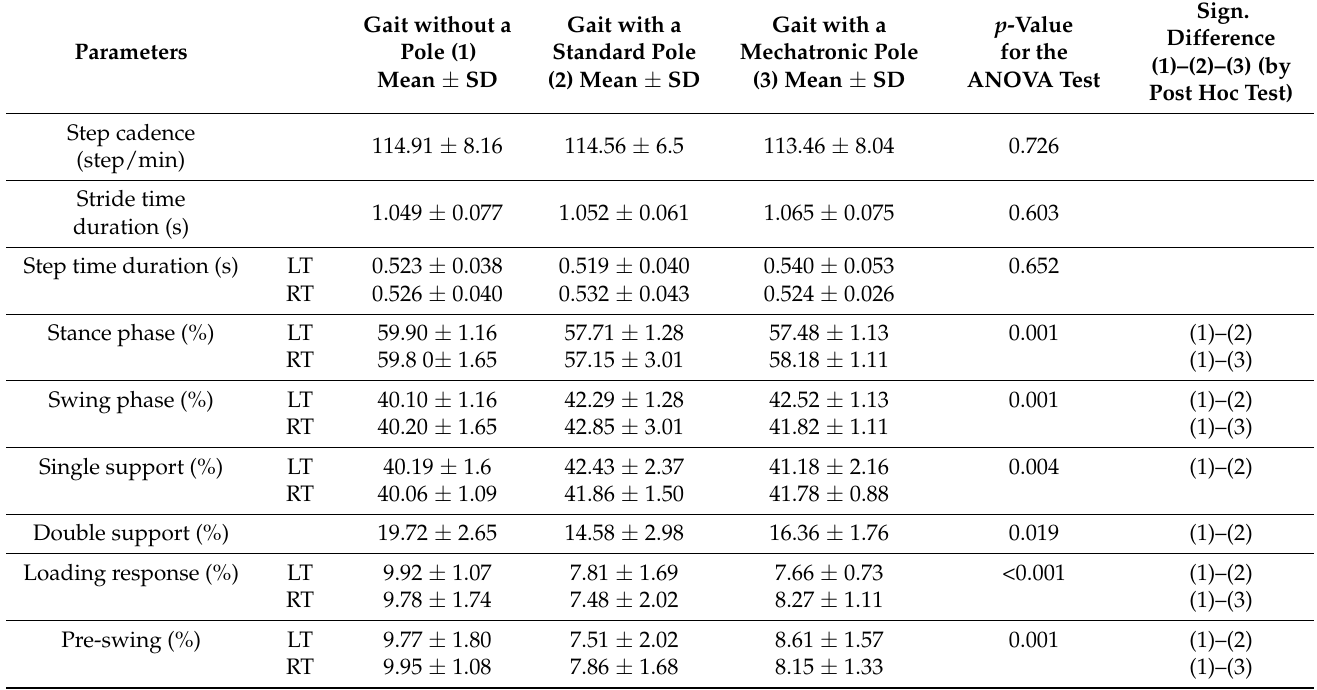
Table 2. Differences between measurements of temporal gait parameters: without a pole (1), with a standard pole (2), and with a mechatronic pole (3) for Nordic Walking professionals ( n = 6).